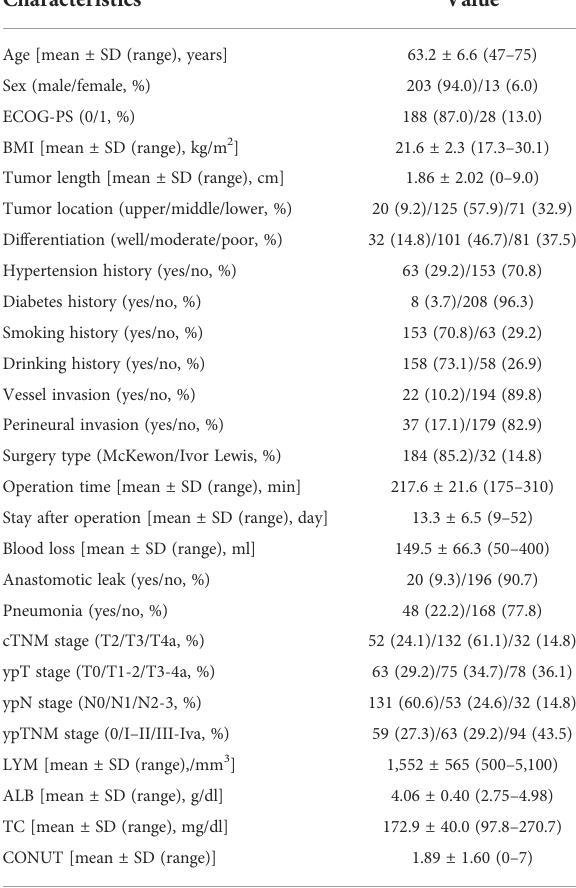
TABLE 1 Clinical characteristics in 216 esophageal squamous cell carcinoma patients.